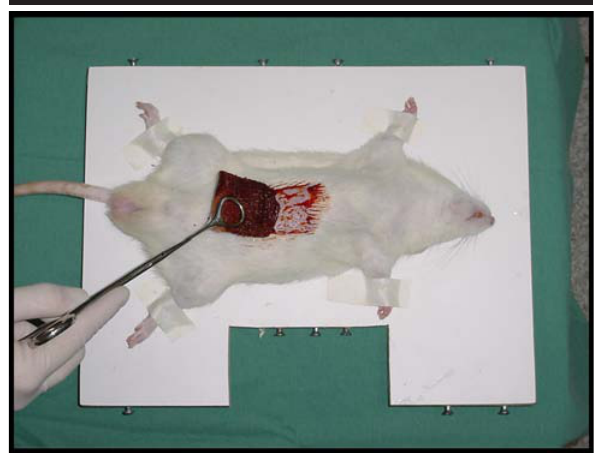
FIGURE 1 - Picture of rat after antisepsis procedure and delimitation of surgical field.